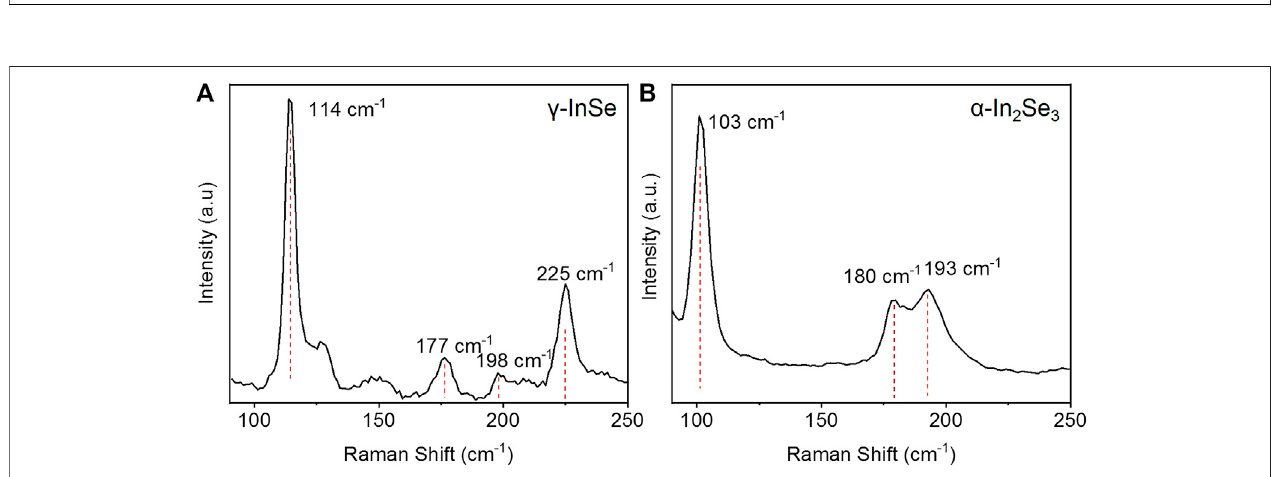
FIGURE 4 | Micro-Raman spectra of γ -InSe fl ake (A) and α -In 2 Se 3 fl ake (B) with excitation laser wavelength of 532 nm.